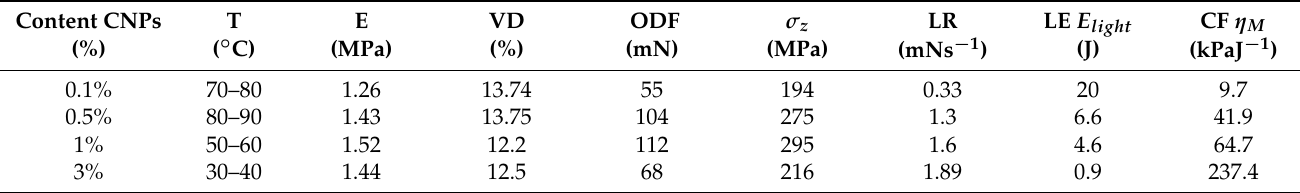
Table 3. Main photomechanical features to be considered for devices with PDMS/CNPs nanocomposites. T = Temperature reached after irradiation, E = Elastic modulus, VD = Volumetric deformation, ODF = Optically driven force, σ z = Normal stress in z direction, LR = Load rate, LE = Light energy, and CF = Conversion factor η M